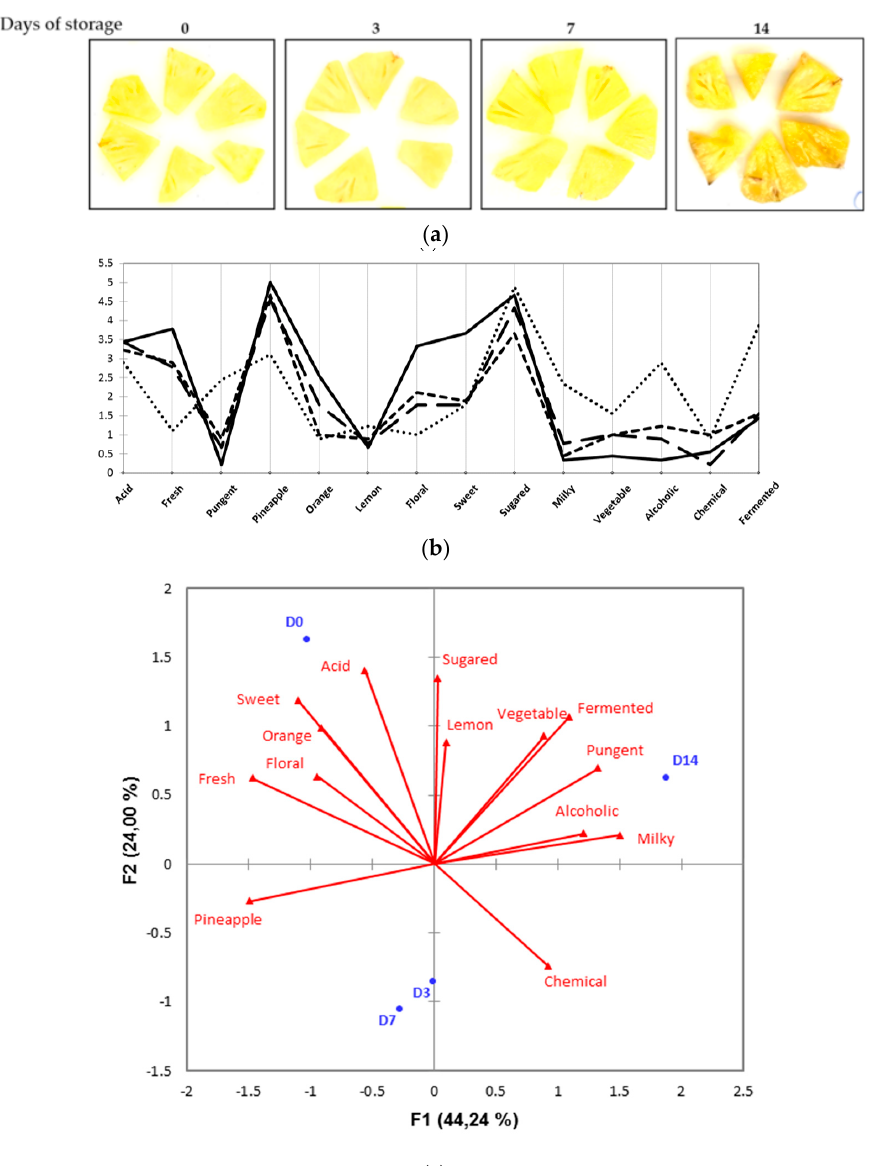
Figure 3. ( a ) Visual aspect of pineapple cuts during storage. From left to right: 0, 3, 7 and 14 days of storage at 4°C; ( b ) Olfactive descriptive profiles of minimally-processed pineapple stored at 4 °C for 0 days (plain line), 3 days (large dashes), 7 days (short dashes) or 14 days (dotted line); ( c ) PCA analysis of olfactive profiles. Sum of F1 and F2 represents 68.24% of data. D0, D3, D7, D14: samples stored at 4 °C for 0, 3, 7, and 14 days respectively.